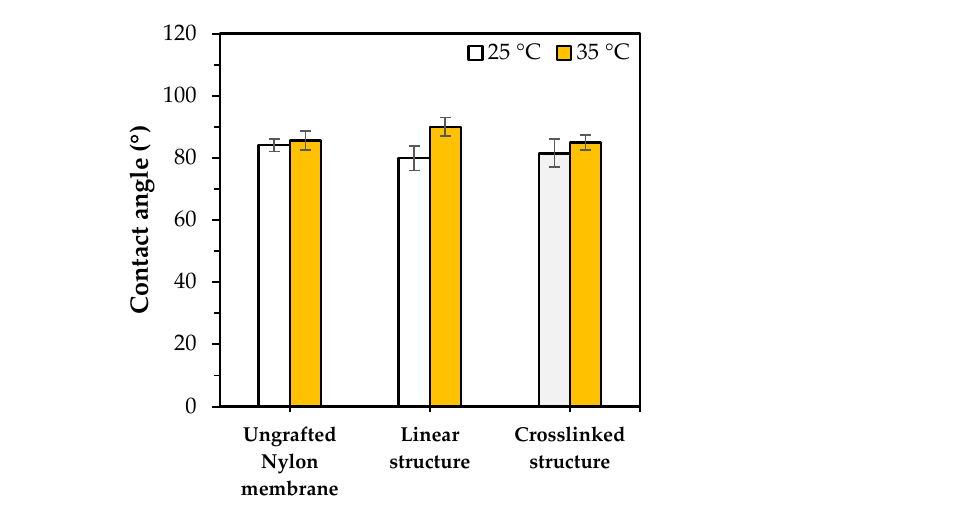
Figure 6. Water contact angles of ungrafted and highly PNIPAm-grafted nylon membranes ( Y > 100%) with different grafting architectures at 25 °C and 35 °C .